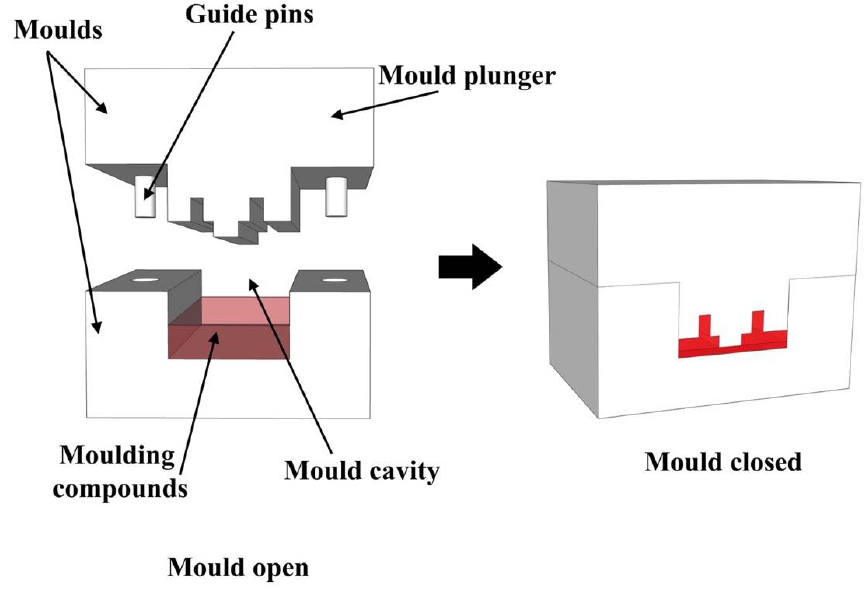
Figure 9. Schematic diagram of compression molding for polymers (redrawn from Ref. [271]). The various processing techniques, components, and the characteristics of the biocomposites that have been reported in the literature are reviewed in Table 6. Table 6. Processing of various